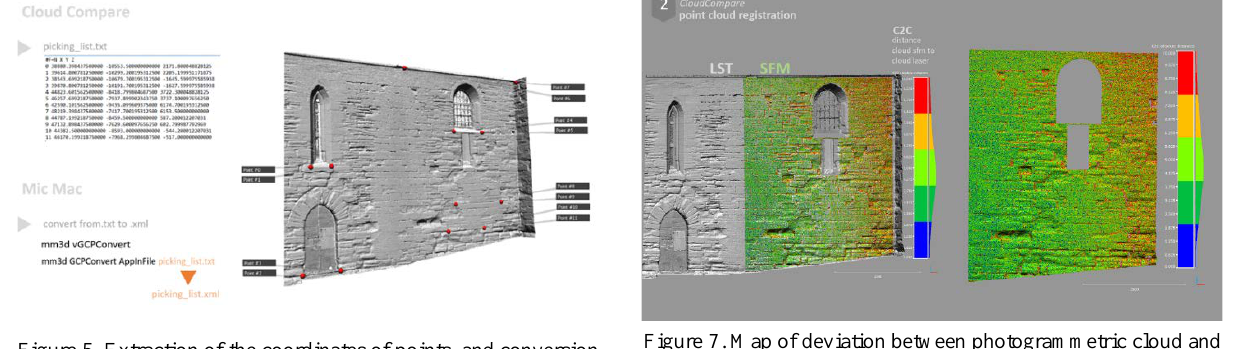
Figure 5. Extraction of the coordinates of points, and conversion of the list for the scale, geo-referencing and validation of the photogrammetric model.